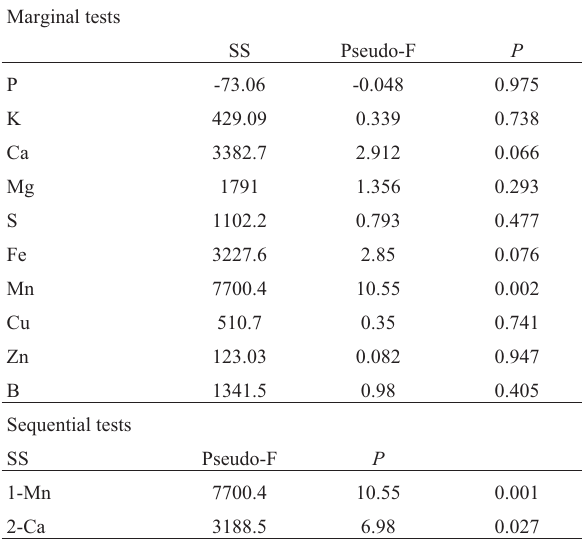
Table 6 - Marginal and sequential tests (distance-based linear model, DistLM) of environmental variables and the abundance of bacterial or-